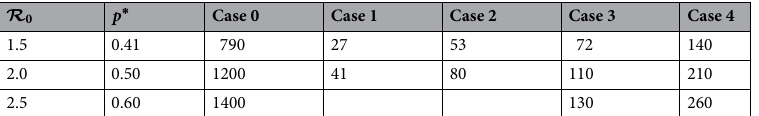
Table 2. The minimum mortality to acquire herd immunity (thousand deaths). A blank cell indicates that the share of the active group n for that settings is too small to develop herd immunity for the whole population (i.e., n < p ∗